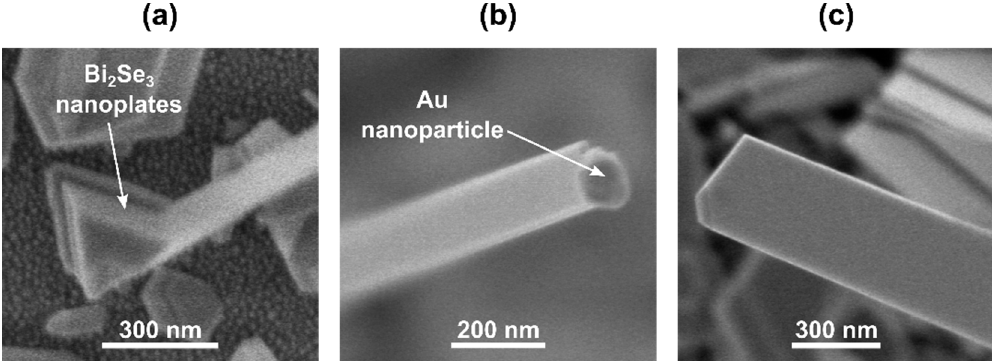
Figure 4. SEM images of synthesized Bi 2 Se 3 nanostructures: ( a ) Nanoplates at the base of a nanoribbon; ( b ) nanoribbon with a Au nanoparticle at the tip; ( c ) nanoribbon with no Au nanoparticle droplet at the tip.